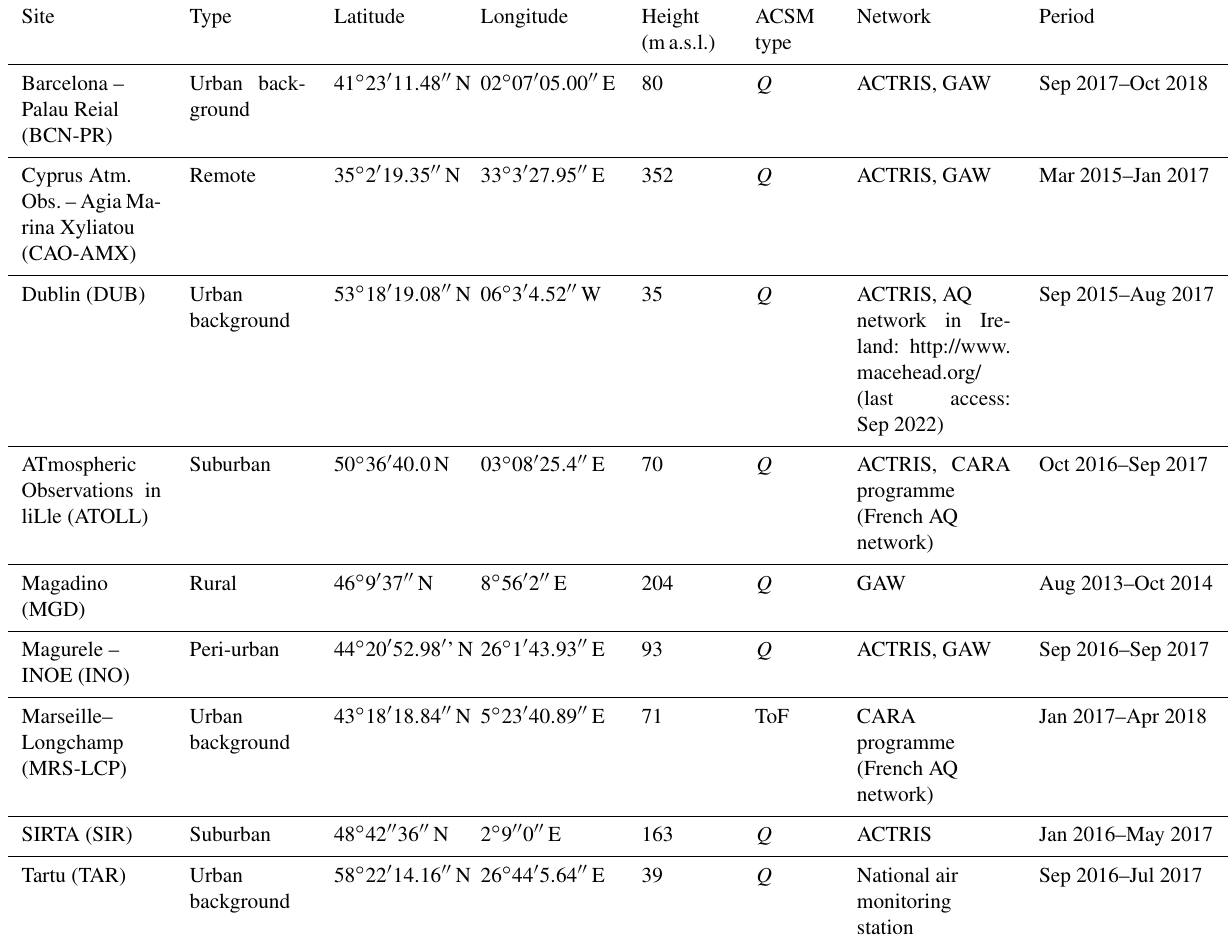
Table 1. Participant